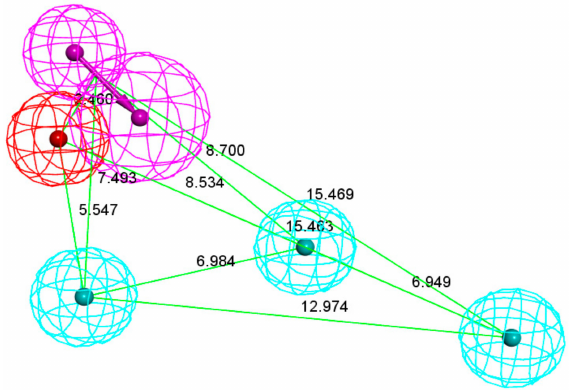
Figure 3. Pharmacophore model 1B. As the figure shows, the positive ionizable point is red, the hydrophobic point is blue, and the hydrogen bond donor is purple.